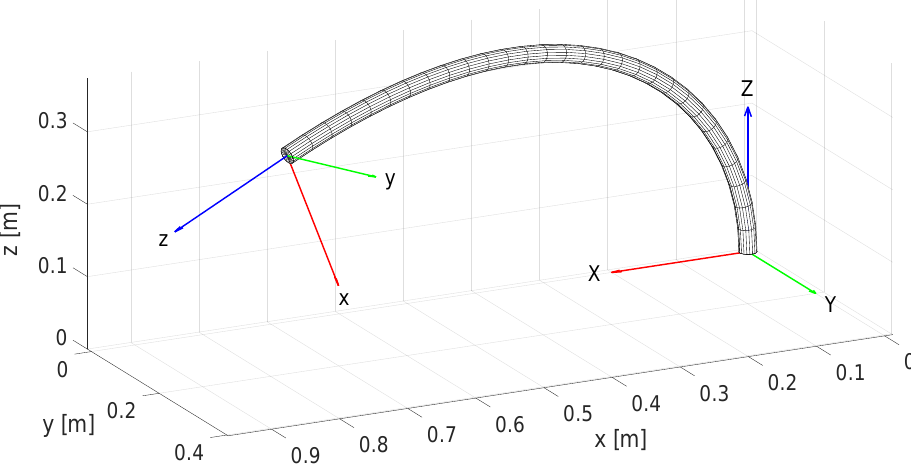
Figure 1. A rod deformed in space, along with frames used. For the unloaded pre-curved state of the rod, the magnitudes described above are designated with the subscript ◦